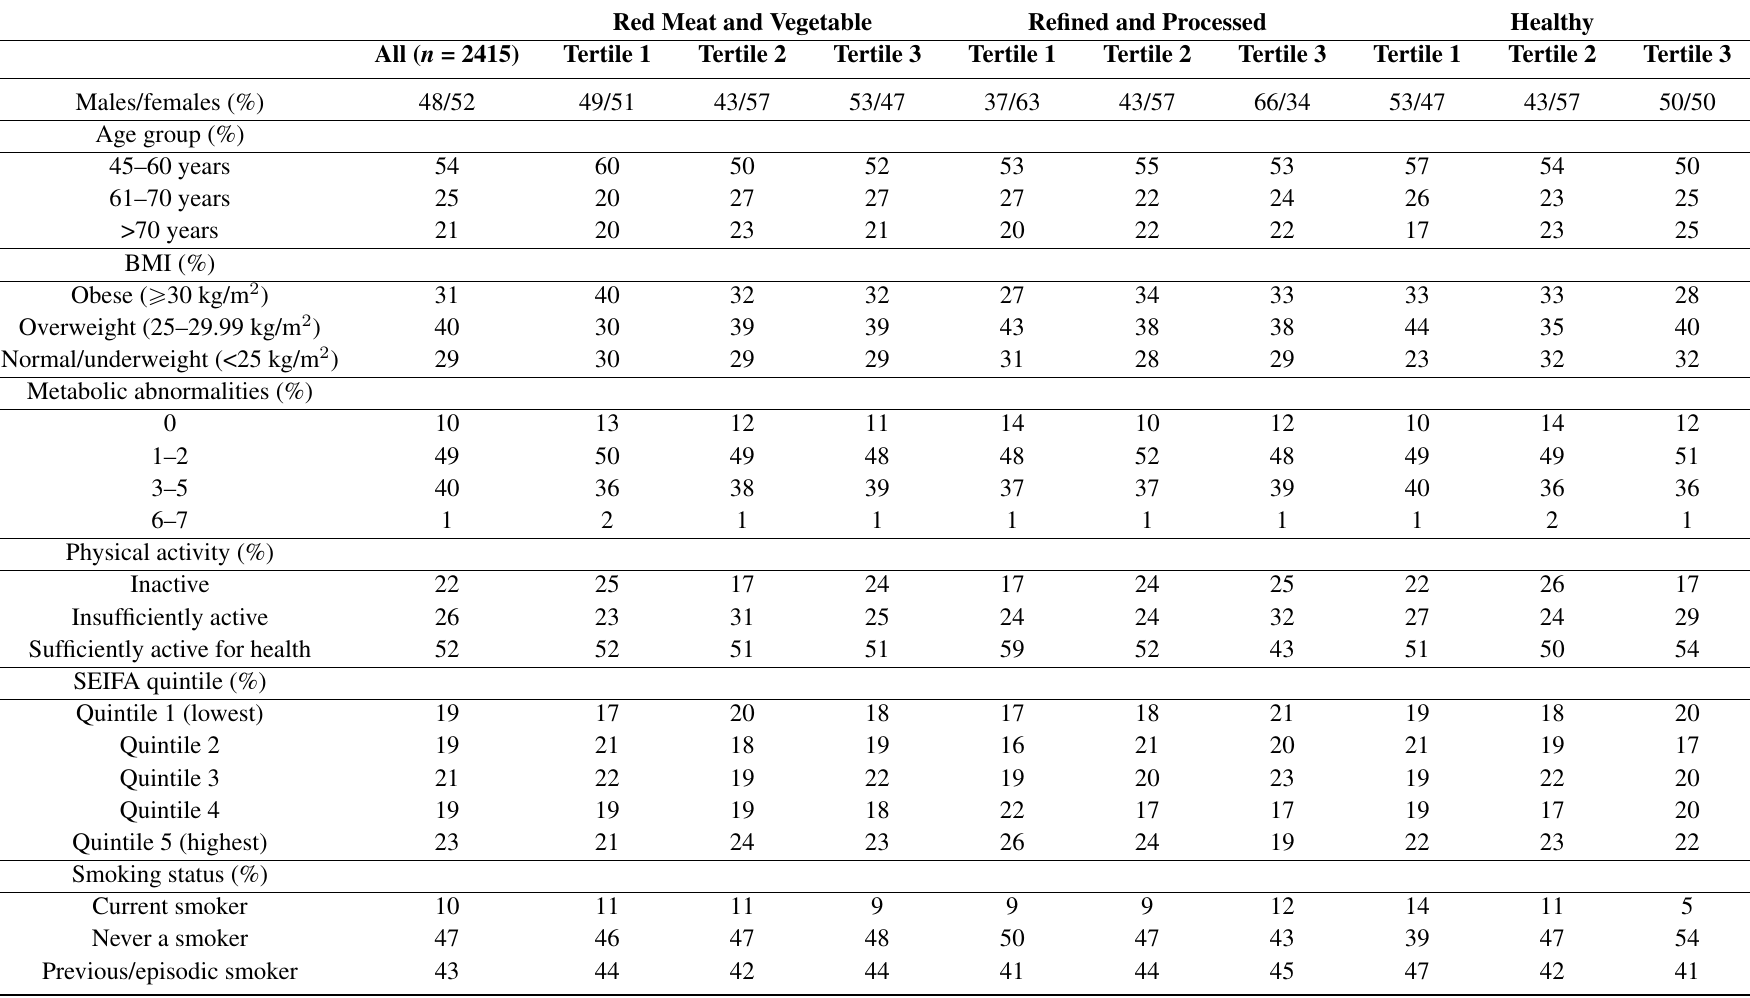
Table 1. Descriptive characteristics of the Australian sample aged 45 years and over, participating in the 2011–2013 Australian Health